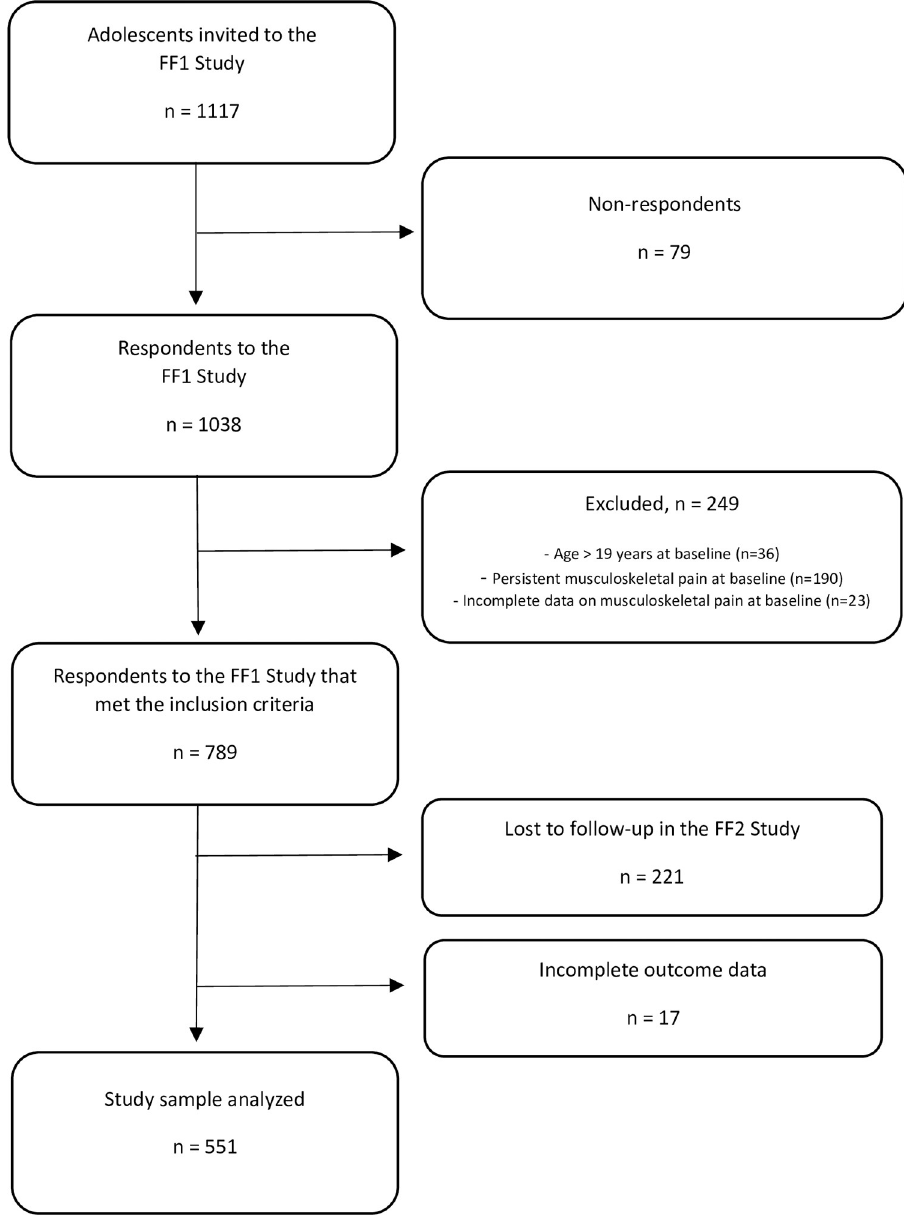
Fig 1. Flow chart of the study